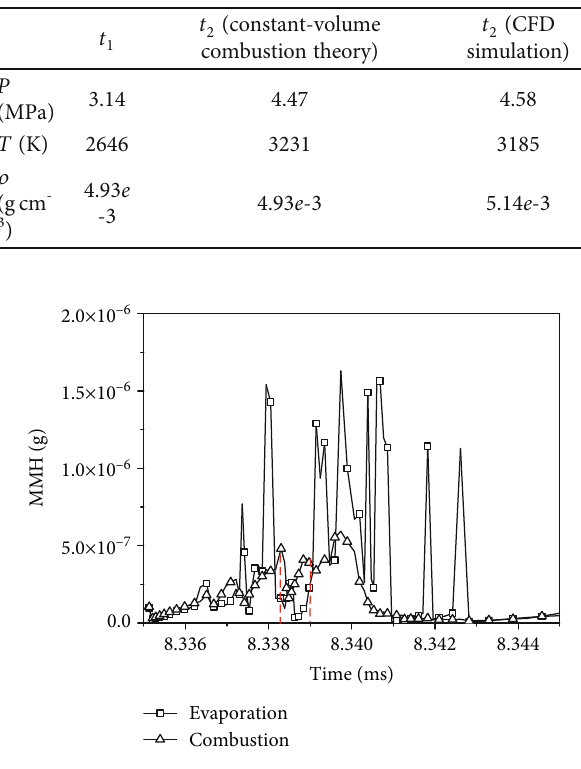
Figure 10: The evaporation amount and consumed amount due to the combustion of MMH.